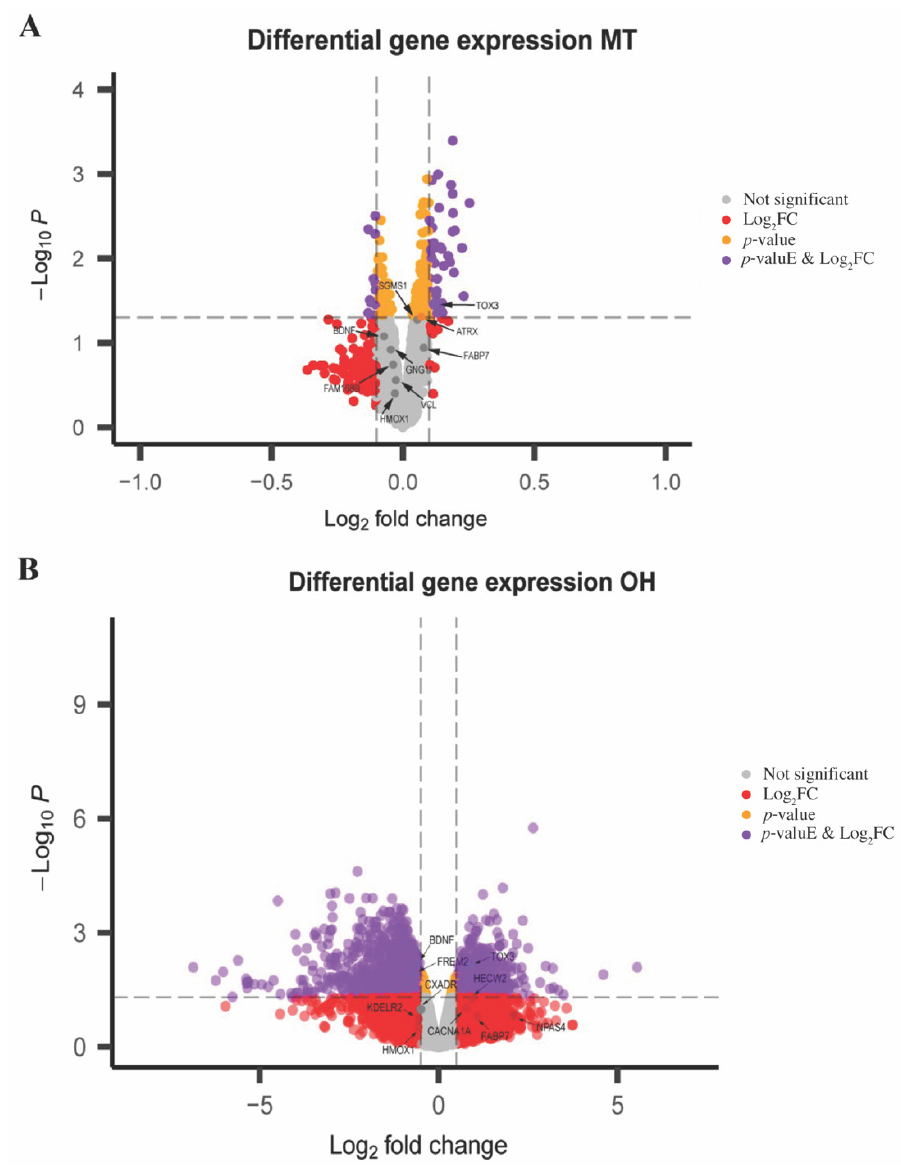
Figure 7. Volcano plot showing similarities in differentially expressed genes between the skyblue module and selected datasets. ( A ) Volcano plot of shared gene expression profiles from patients with RTT and age matched controls within skyblue and MT. The log 2 FC ( x -axis) of each gene is plotted against the − log 10 P ( y -axis). Expression difference is considered significant for log 2 FC of 0.1, and p -value < 0.05, as indicated by the purple-coloured points. The grey points represent genes with non-significant differences in expression. ( B ) Volcano plot of similarly differentially expressed genes in the skyblue module and OH dataset comparing patient-derived neuronal samples and controls. The log 2 FC ( x -axis) of each gene is plotted against the − log 10 P ( y -axis). Significant differences in gene expression, where log 2 FC is 0.5, and p -value < 0.05, are depicted by the purple points. The grey points represent genes with non-significant differences in expression.